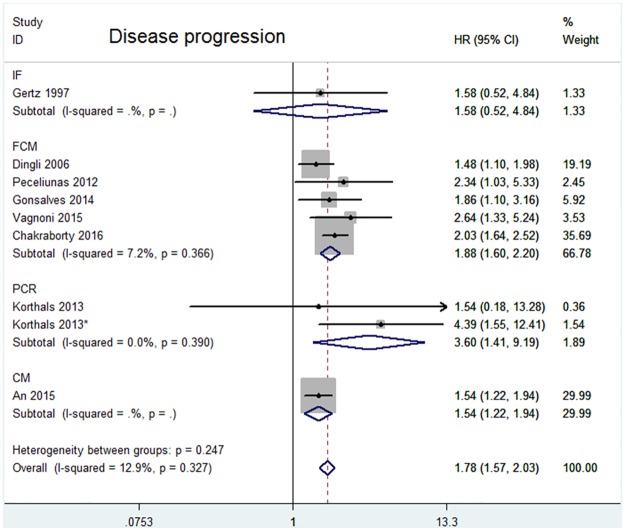
Forest plot of HRs and 95%CIs for disease progression.Subgroup analysis was according to different detection methods. The black boxes’ sizes are proportional to the study weight, with the lines indicating 95% confidence intervals (CIs).